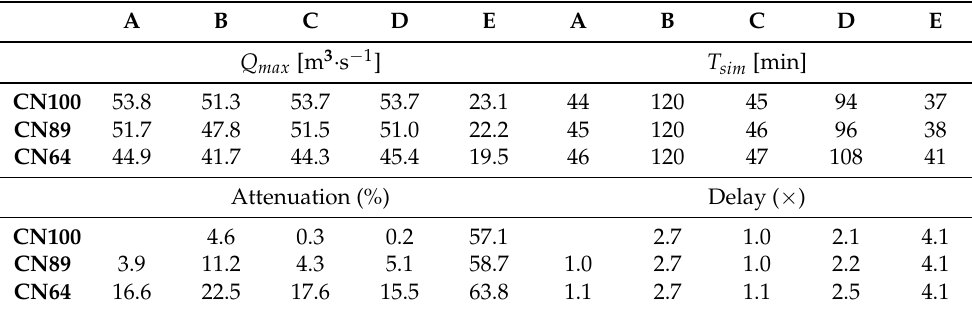
Figure 9. Hydrograph at the basin outlet for the fifteen physical scenarios. Table 1. Peak water discharge Q max and time of concentration T sim for the simulated hydrographs in Figure 9. The attenuation of the peak discharge regarding the maximum value of scenario CN100-A and the delay factor of the time to peak flow are also